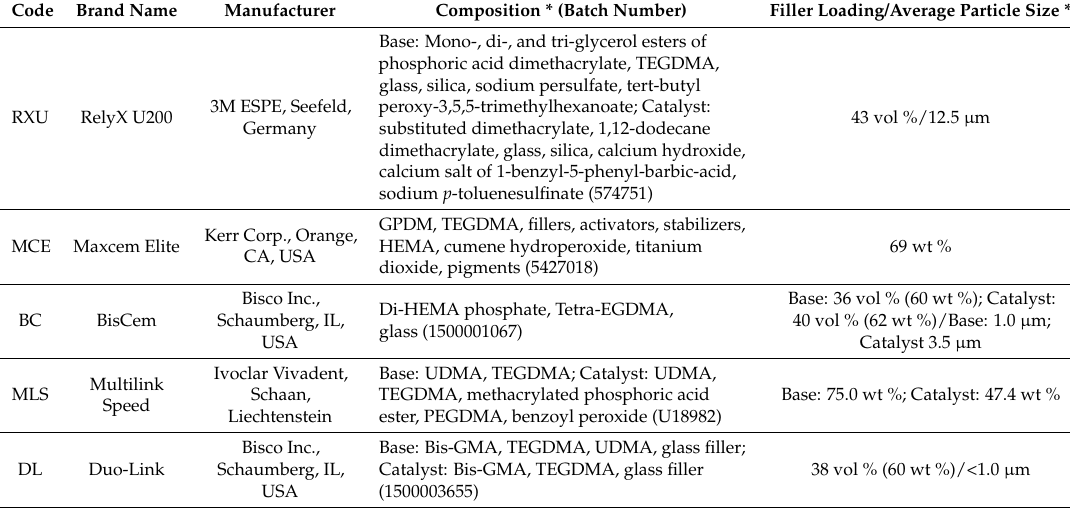
Table 1. Materials used in the present